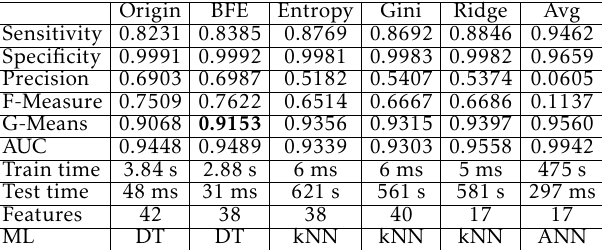
Table 6. Compare IG-BFE with other algorithms on WORMS.